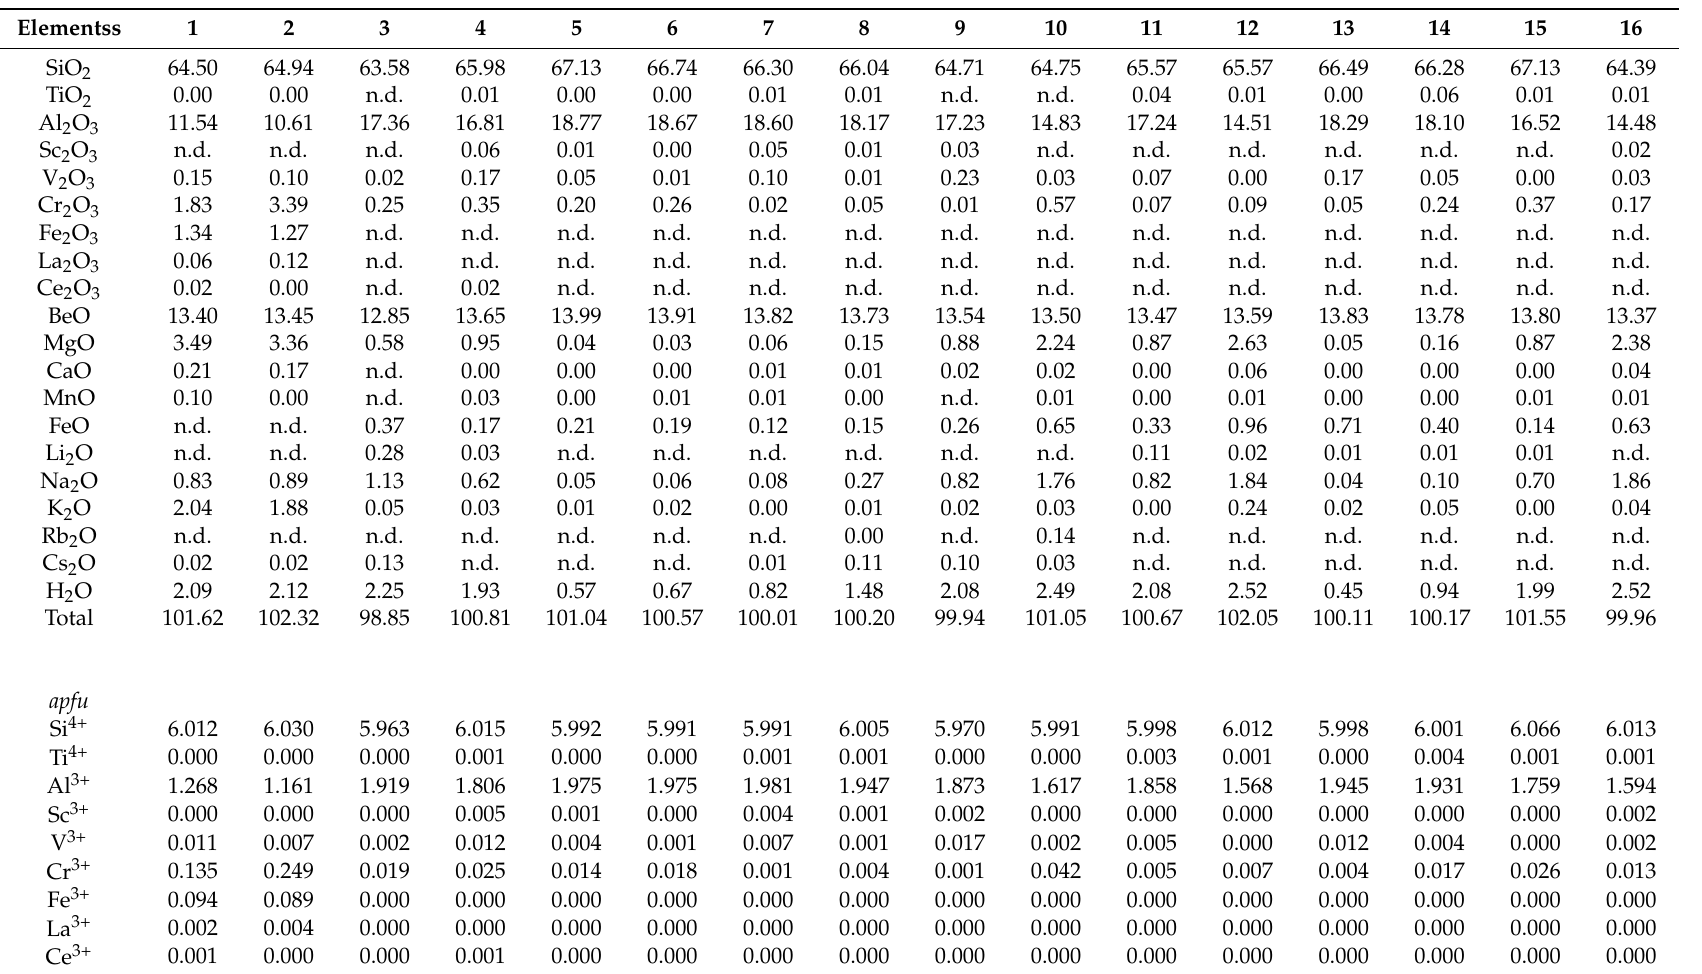
Table 1. Representative composition with the structural formulas of emerald samples from the recent literature (in wt.%) 1 .